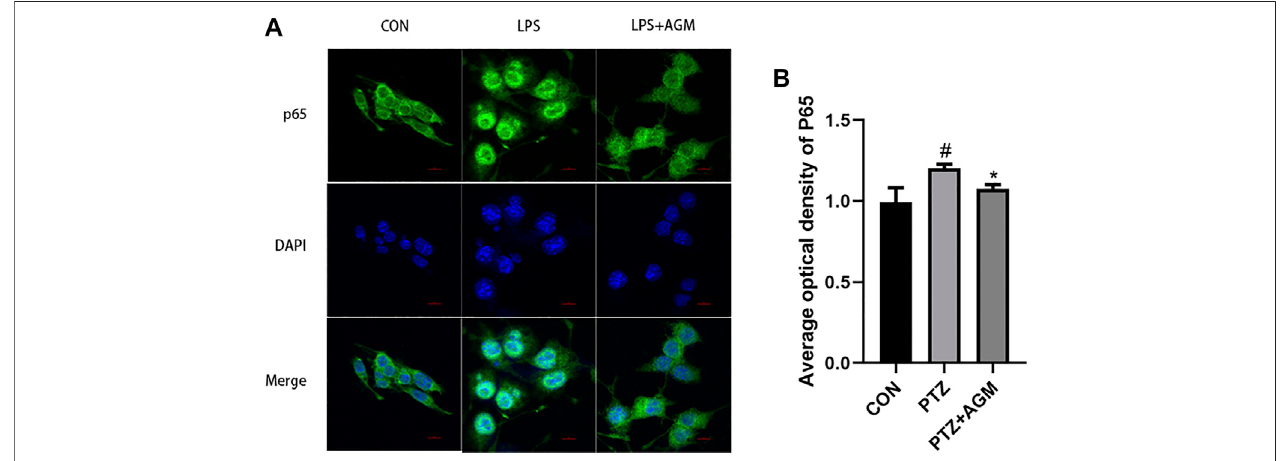
FIGURE 8 | Effects of AGM on the expression of P65 activated by LPS-induced BV2 microglial cells. (A) Representative images (original magni fi cation, × 400) of immuno fl uorescence staining of P65 in BV2 microglial cells. Scale bar (cid:1) 100px. (B) Semi-quantitative analysis of the relative levels of P65 by densitometric analysis (Student ’ s test). # p ＜ 0.05 vs the control and LPS group, * p ＜ 0.05 vs the LPS group and LPS + AGM